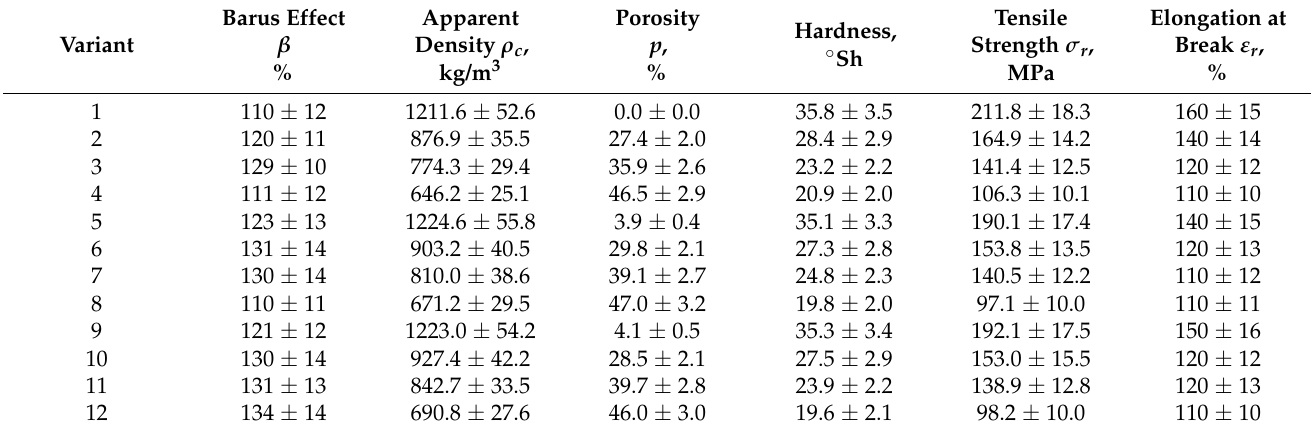
Table 2. Values of the analyzed characteristics of the